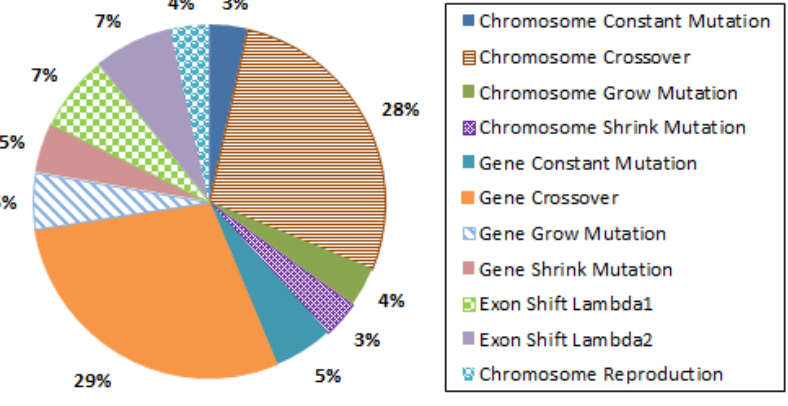
Figure 4. Genetic operations performed as percentage when ranking images by semantics.